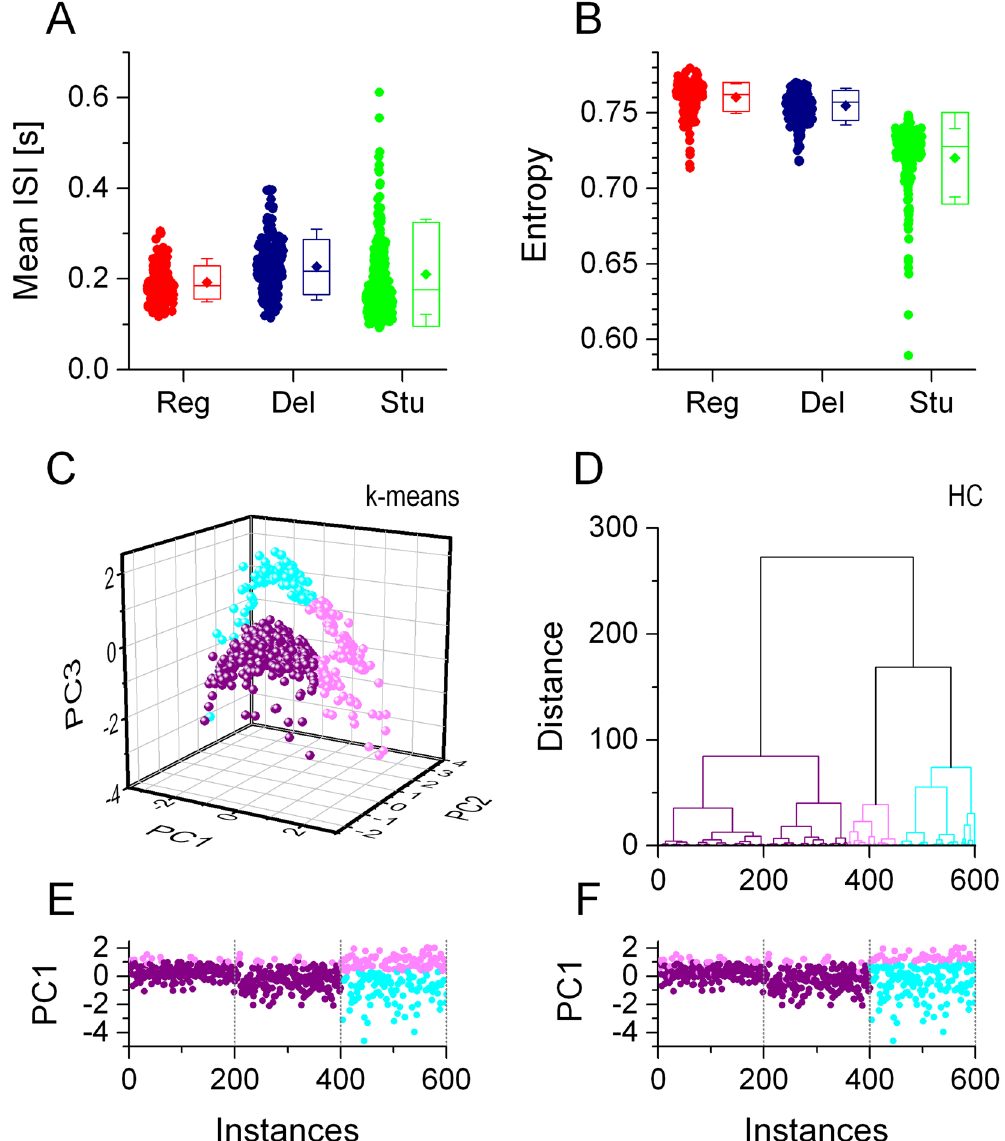
Figure 5. K-means and hierarchical clustering of neurons based on their interspike interval statistical parameters does not reproduce the distribution of the 3 biophysical phenotypes. Mean interspike interval data are shown for the 3 biophysical phenotypes in ( A ). The different model implementations exhibit a high variance in the mean ISI values and populations corresponding to the 3 groups largely overlap. ( B ) ISI-entropy values calculated from the firing responses shown for the 3 phenotypes. Stuttering type models exhibit lower entropy in the firing responses. ( C ) 3-dimensional plot of PC vectors clustered by the k-means algorithm. The majority of vectors from instances 1 to 400 are grouped together and represented by purple colored symbols ( E ). Hierarchical clustering of the same data yields a similar distribution ( D,F